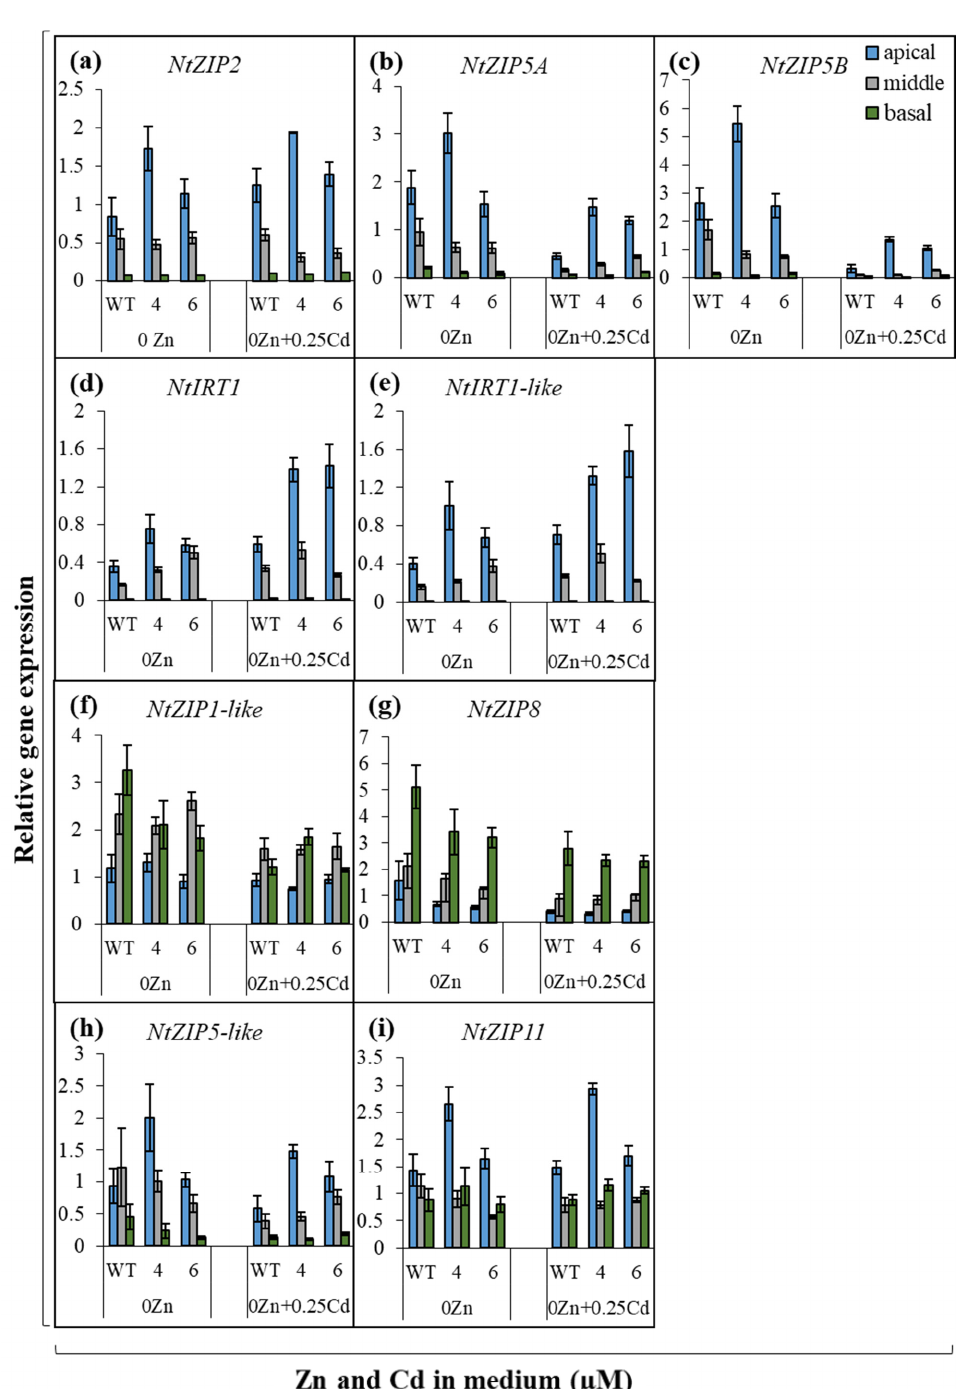
Figure 7. Expression of tobacco ZIP genes in the apical, middle, and basal parts of wild-type and NtZIP4A / B -RNAi plants grown at Zn deficient medium with or without 0.25 µ M Cd. 3.5-week- old plants of wild-type (WT) and NtZIP4A / B -RNAi lines (number 4 and number 6) grown in the quarter-strength Knop’s medium were exposed for 17 days to the Zn-deficient medium (Zn was not added to the medium) with or without 0.25 µ M Cd. Expression of NtZIP2 ( a ), NtZIP5A ( b ), NtZIP5B ( c ), NtIRT1 ( d ), NtIRT1-like ( e ), NtZIP1-like ( f ), NtZIP8 ( g ), NtZIP5-like ( h ), and NtZIP11 ( i ). Gene expression was normalized to the PP2A level. Values correspond to arithmetic means ± SD ( n = 3); those with a ratio greater than 2 are considered significantly different